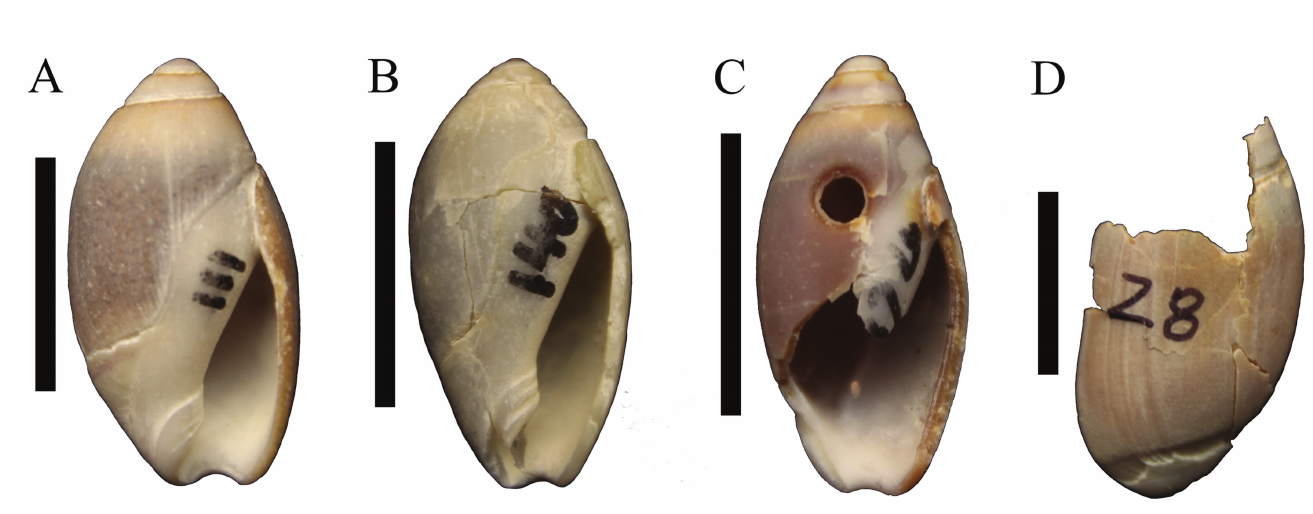
Figure 1. Examples of Olivella biplicata shells displaying compactional damage thresholds used to infer compactional